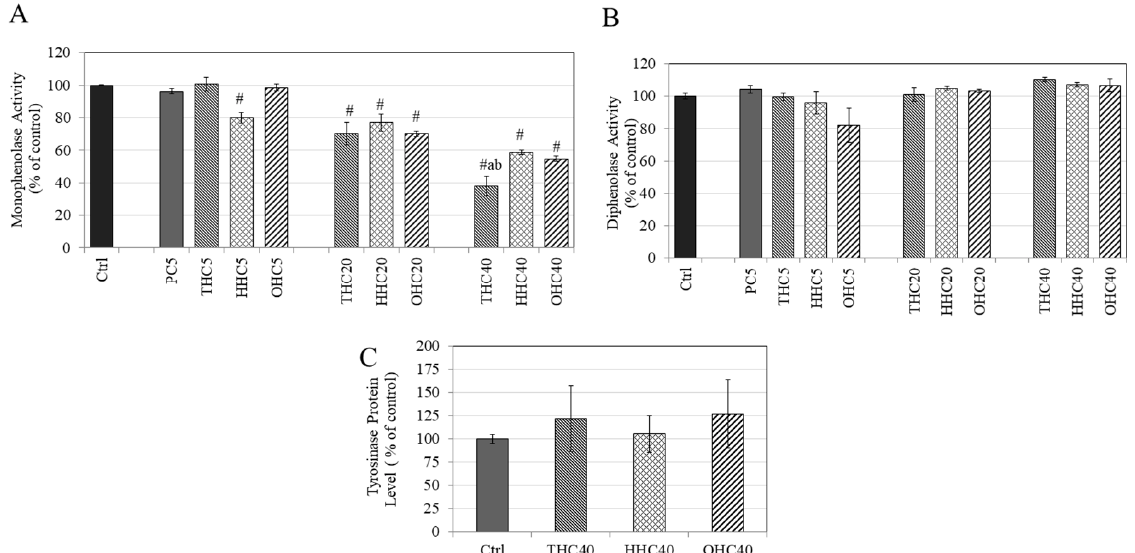
Figure 3. Effect of PC, THC, HHC, and OHC on ( A ) monophenolase activity and ( B ) diphenolase activity of mushroom tyrosinase; (# p < 0.001 vs. Ctrl; letter a— p < 0.001 vs. HHC40; letter b— p < 0.01 vs. OHC40; One-way ANOVA followed by Tukey’s test); ( C ) Tyrosinase protein levels in B16F10 cells treated with 40 µ M of THC, HHC, and OHC for 3 d and protein levels were measured by ELISA; All data is mean ± SD of triplicates.